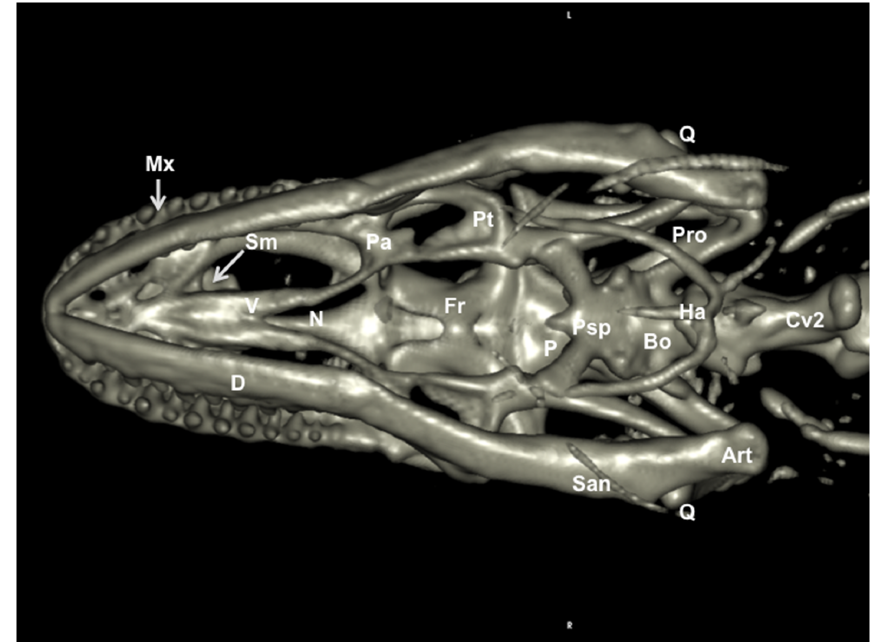
Figure 8. Three-dimensional volume-rendered reconstruction image of the cranium of Varanus komodoensis . Ventral aspect. Mx: Maxillary bone. D: Dentary bone. San: Surangular bone. Art: Articular bone. Q: Quadrate bone. Bo. Basioccipital bone. Psp: Parabasisphenoid bone. Pro: Prootic bone. Pt: Pterygoid bone. Pa: Palatine bone. V: Vomer. Sm: Septomaxilla. N: Nasal bone. Fr: Frontal bone. P: Parietal bone. Ha: Hyoid apparatus. Cv2: Second cervical vertebra.